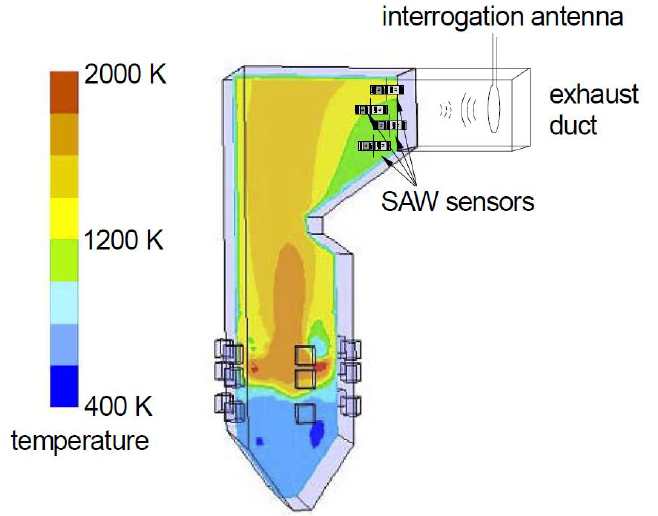
Figure 1. Concept for sensors in the exhaust of an oxy-fuel combustion system (120 MWh, wet recycle). Multiple sensors can be interrogated using a single antenna. Combustion takes place near the bottom with the exhaust at the top and to the right. Colors indicate temperature. Figure adapted from